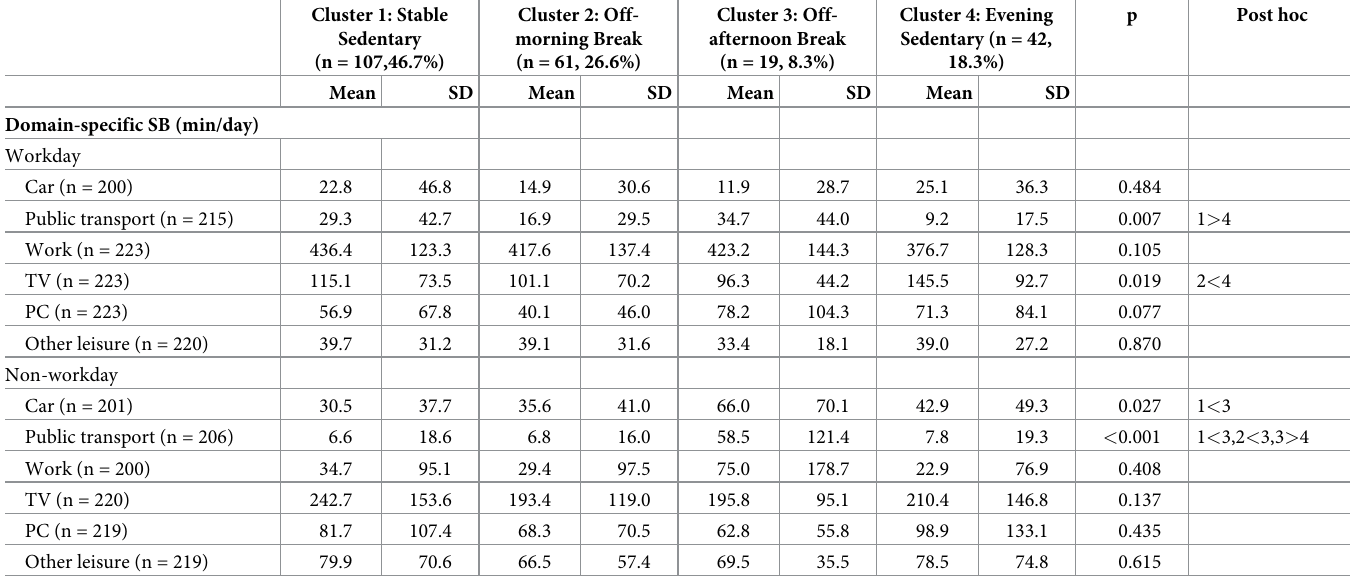
Table 3. Differences in domain-specific sedentary behavior by